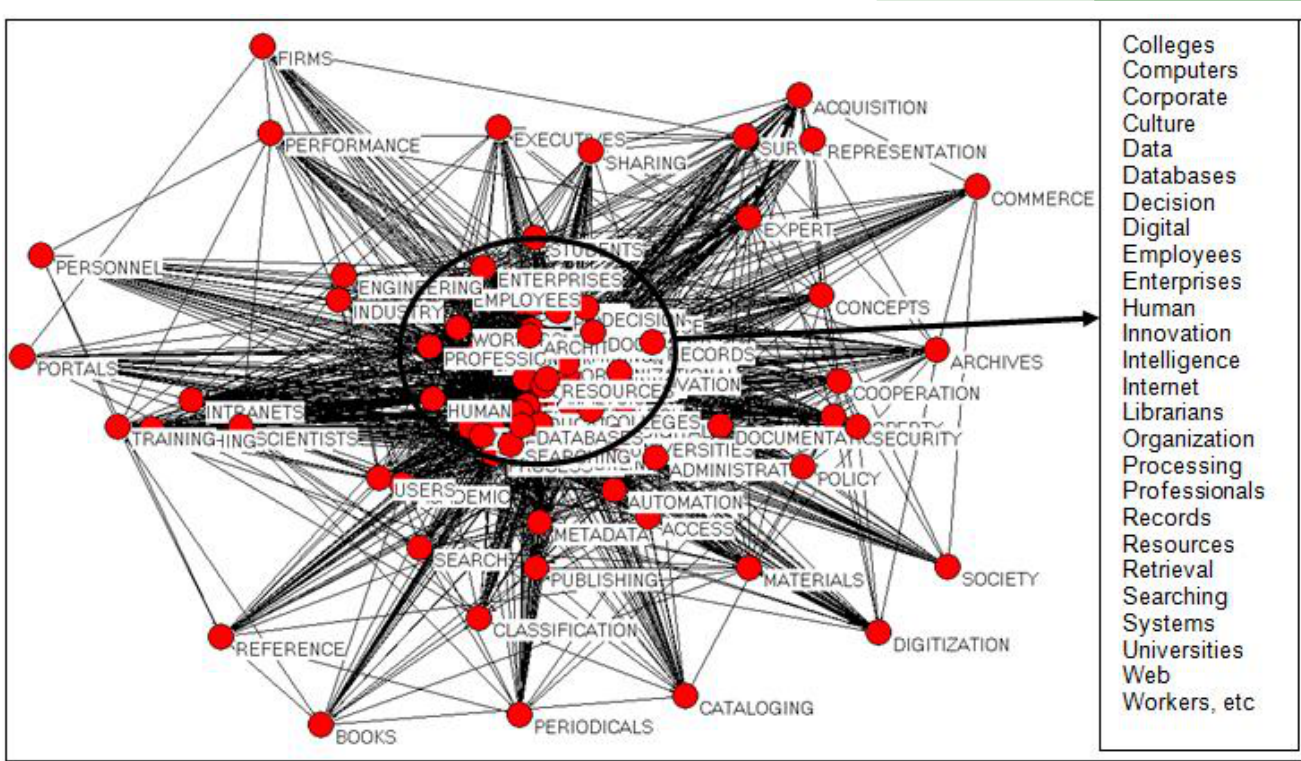
Figure 8 Visual map of core/periphery terms describing KM literature